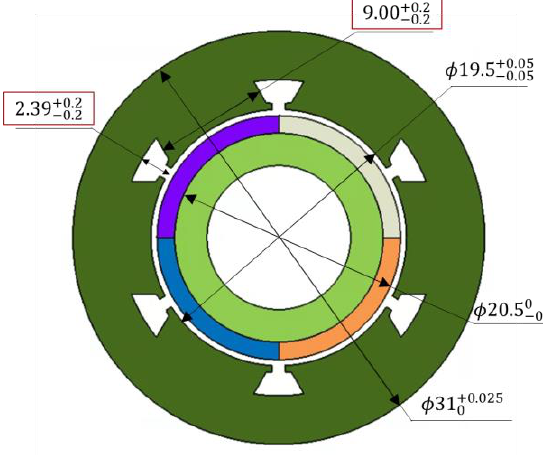
Figure 16. Design tolerance of the design parameters.